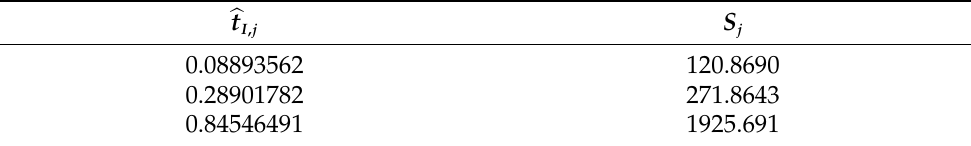
Table 5. Study of infected: Estimated inflection time